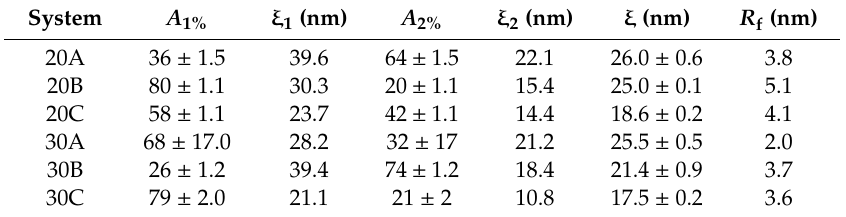
Table 4. Mesh size distribution ( A i% , T 2i ) corresponding to the six studied